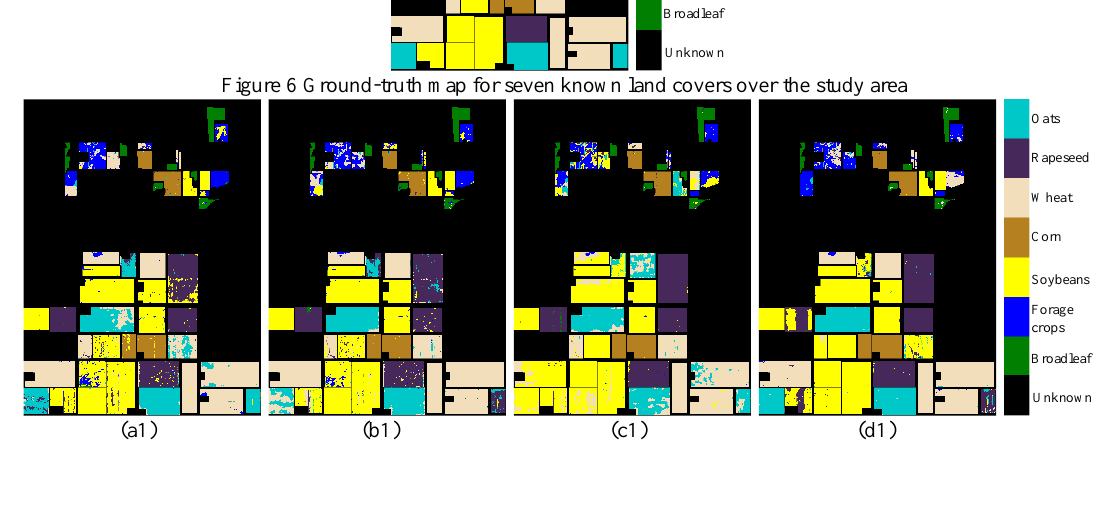
Figure 6 Ground-truth map for seven known land covers over the study